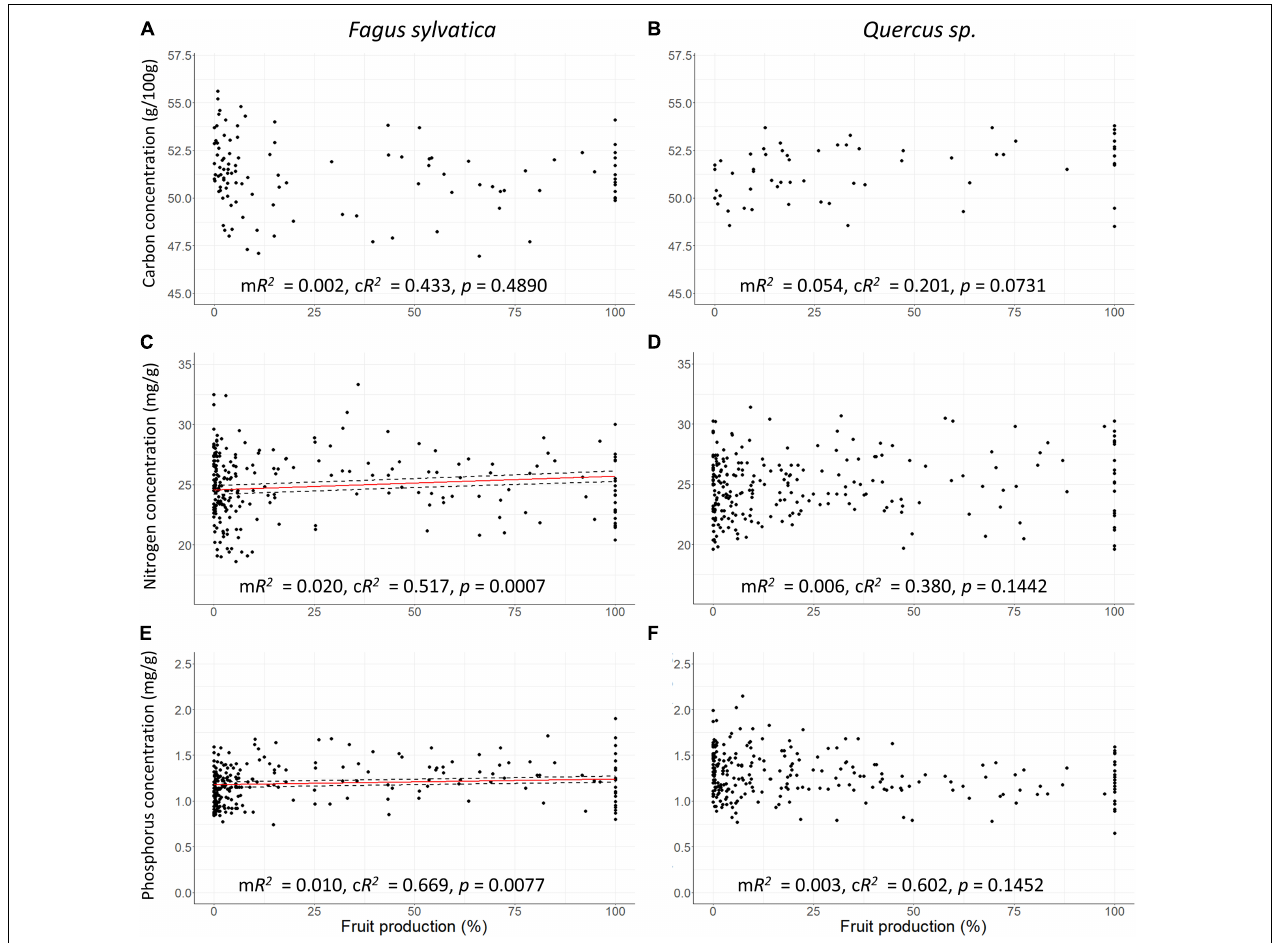
FIGURE 5 | Scatter plots of leaf carbon concentration in g/100g, nitrogen and phosphorus concentrations in mg/g vs. fruit production in percentage of maximum values per plot at European scale. (A , B) Carbon concentration, (C,D) nitrogen concentration, (E,F) phosphorus concentration, (A,C,E) Fagus sylvatica , (B,D,F) Quercus sp. Red line: Response curve of the linear mixed-effects modelling, dashed line: Standard errors, m R 2 : Marginal R 2 , c R 2 : Conditional R 2